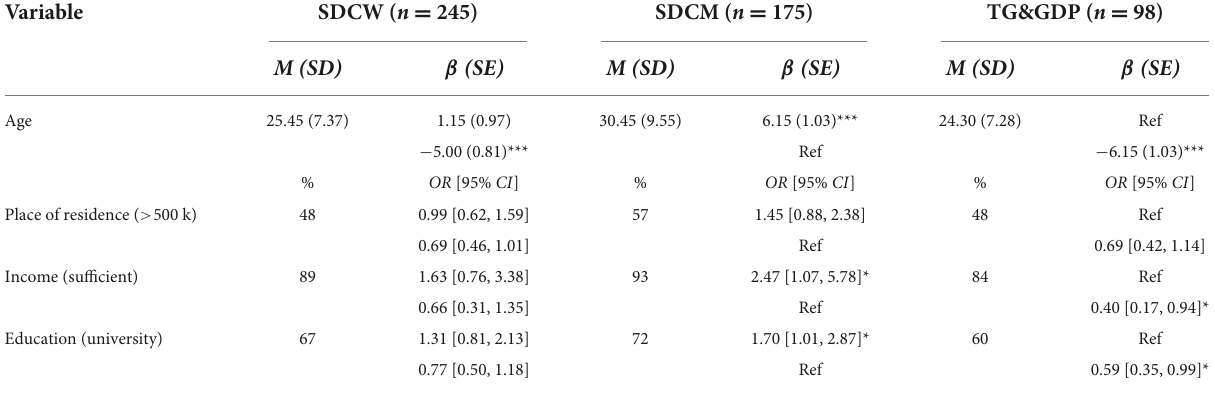
TABLE 1 Comparison of sociodemographic characteristics across distinguished groups of participants.